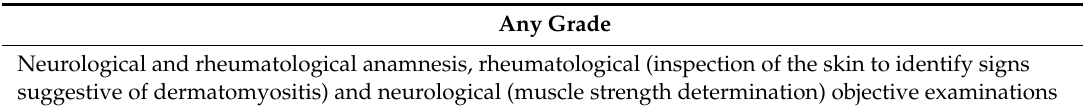
Table 2. Diagnostic approach to ICI-related PM /